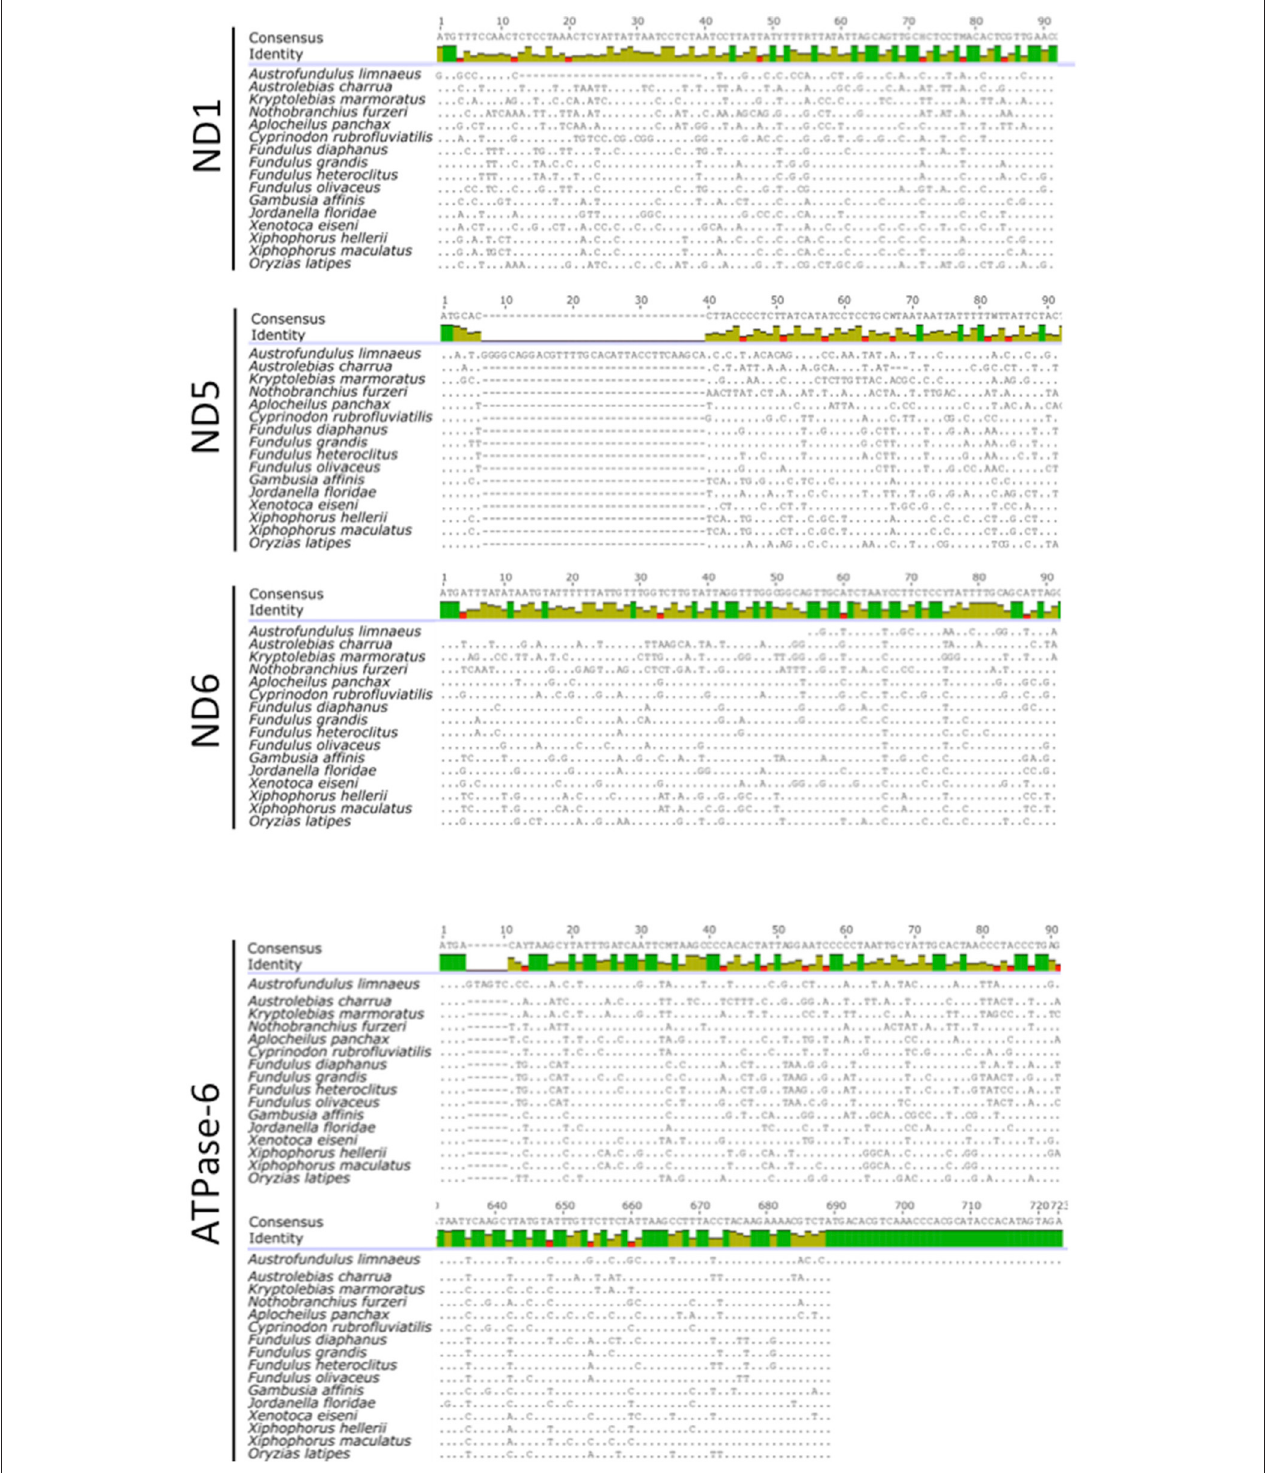
FIGURE 3 | Alignments of A. limnaeus ND1 , ND5 , ND6, and ATPase-6 genes to other species. When compared to other species, there are apparent multinucleotide deletions in the 5 ′ region of A. limnaeus ND1 (27 bp) and ND6 (54 bp). ND5 appears to have a multinucleotide insertion near the 5 ′ end when compared to multispecies consensus (33 bps), while ATPase-6 is extended by several nucleotides at the 5 ′ end (6 bp) and 3 ′ end (34 bp).